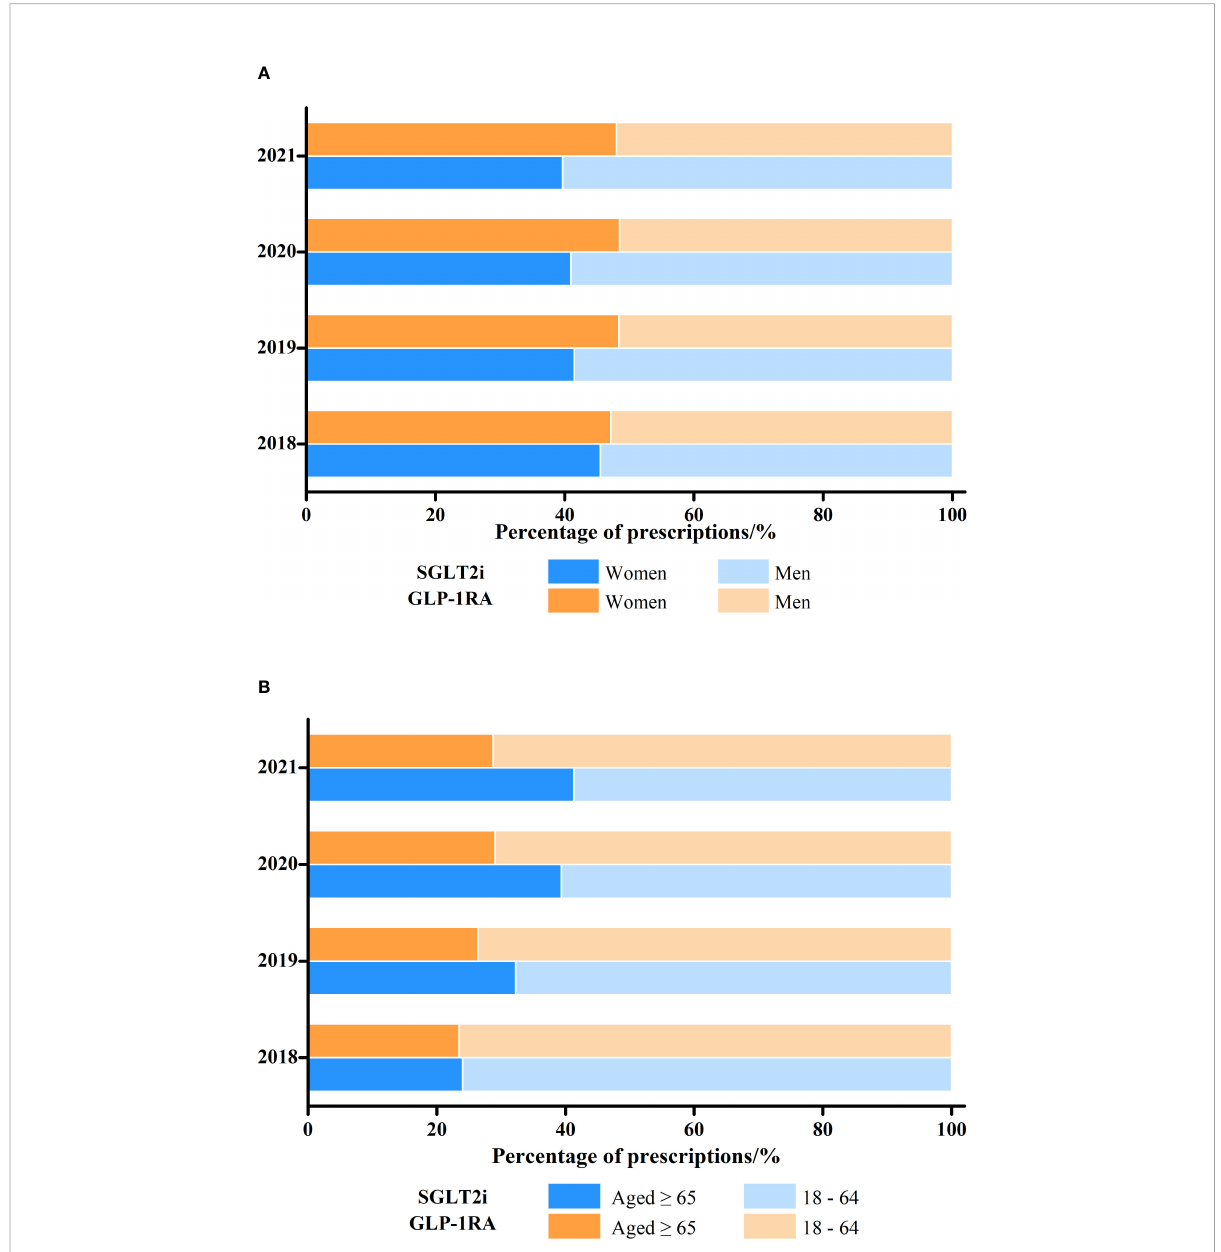
FIGURE 2 Changes in the proportion of SGLT2i and GLP-1RA prescriptions dispensed by (A) patient gender and (B) age,